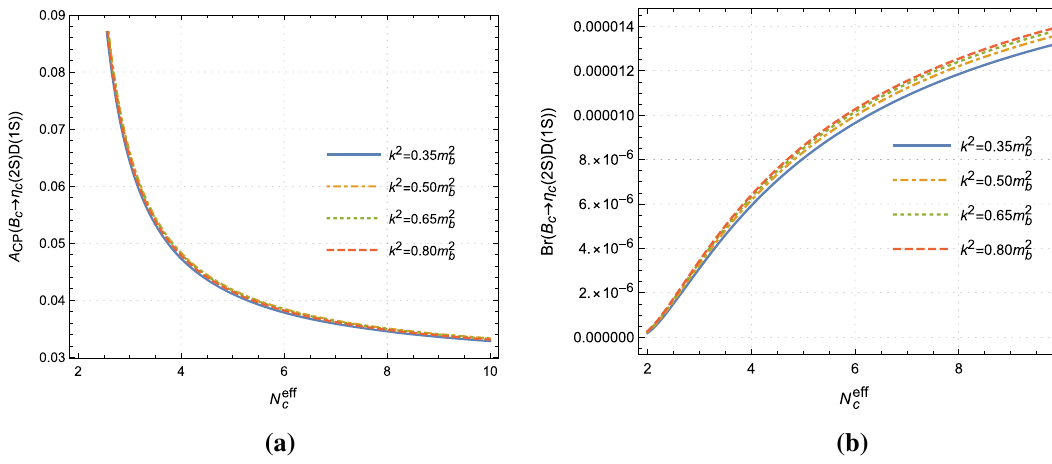
Fig. 4 A cp and averaged branching ratio of B c → η c ( 2 S ) D ( 1 S ) change with k 2 and N ef f c